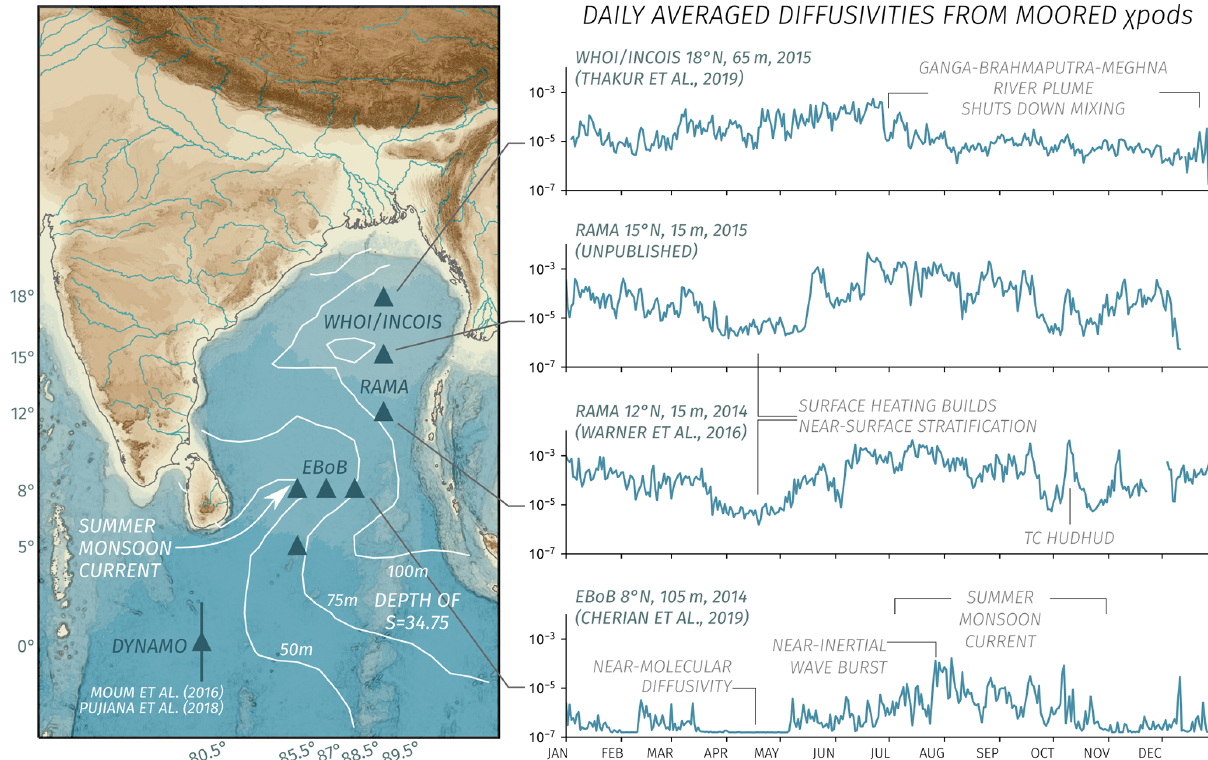
Figure 20. Annual cycle of daily averaged temperature diffusivities derived from χ pod measurements. The data are from 2 different years, 2014 and 2015, depending on location. Note the similar wind-forced seasonal cycle at 12 ◦ N, 15m and 15 ◦ N, 15m and the dramatically different seasonal cycle at 8 ◦ N, 105m (reflecting near-inertial wave activity) and at 18 ◦ N, 65m (reflecting freshwater